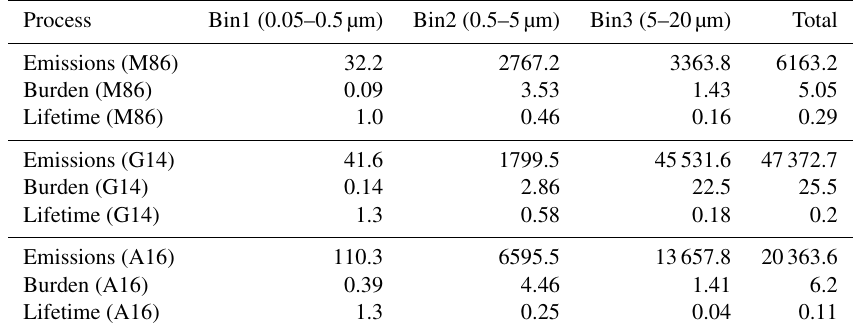
Table 5. Dry sea salt aerosol emissions, burdens and lifetimes simulated by IFS-AER with the M86, G14 and A16 schemes (emissions are in Tgyr − 1 , burdens are in Tg and lifetimes are in d).